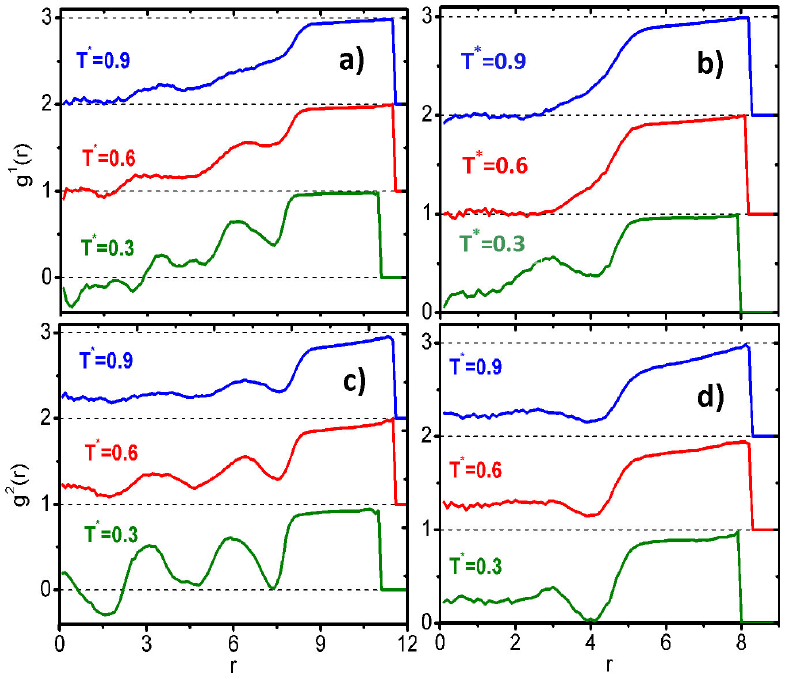
Figure 8. Calculated radial correlation functions, g 1 ( r ) and g 2 ( r ) (see Equation (12)) for G D D ( a , c ) and G ( b , d ) LCDrs at various temperatures. In all plots, the traces are offset 5 3 3 5 for clarity; horizontal dashed lines show zero levels for the correlation functions.